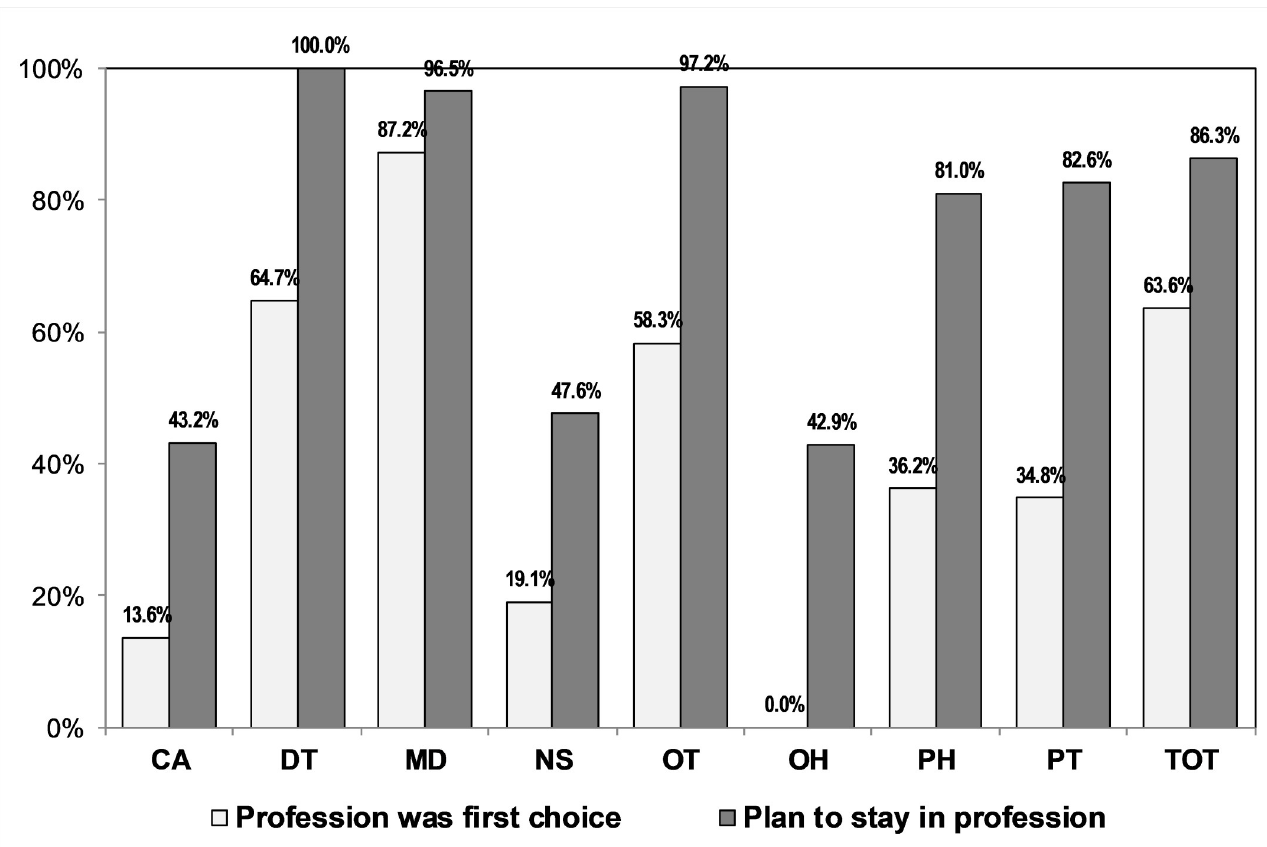
Fig 3. Choice of profession and intention to stay in profession. CA = clinical associate; DT = dentist; MD = medical doctor; NS = nurse; OH = oral hygienist; OT = occupational therapist; PH = pharmacist; PT = physiotherapist.